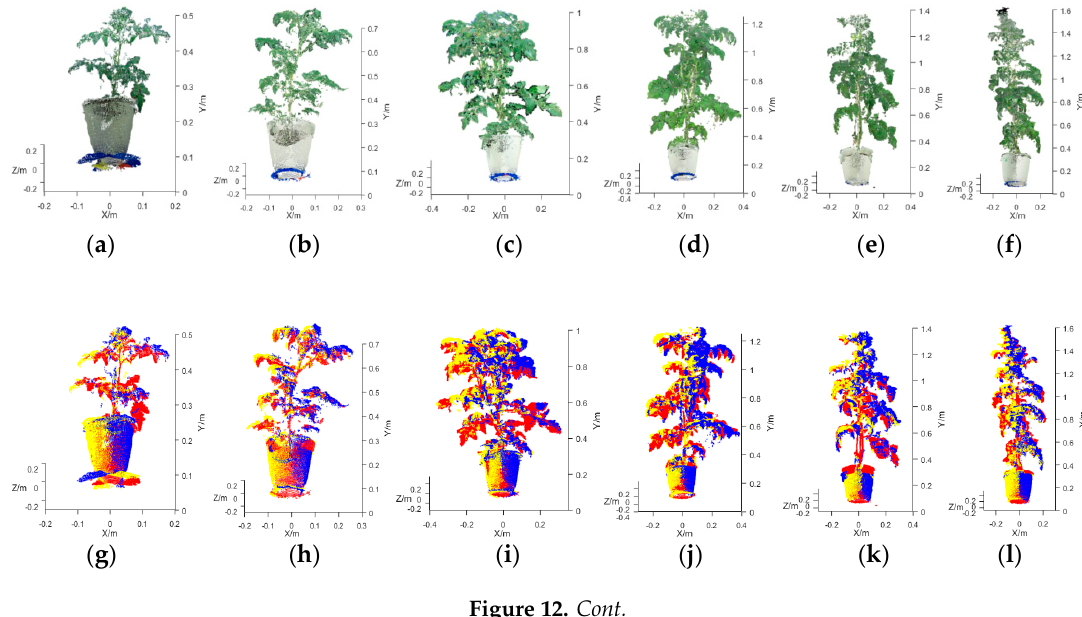
Figure 11. Performance parameters of canopy volume measurement. ( a ) CV of canopy volume, ( b ) R 2 for the calculated and measured values of canopy